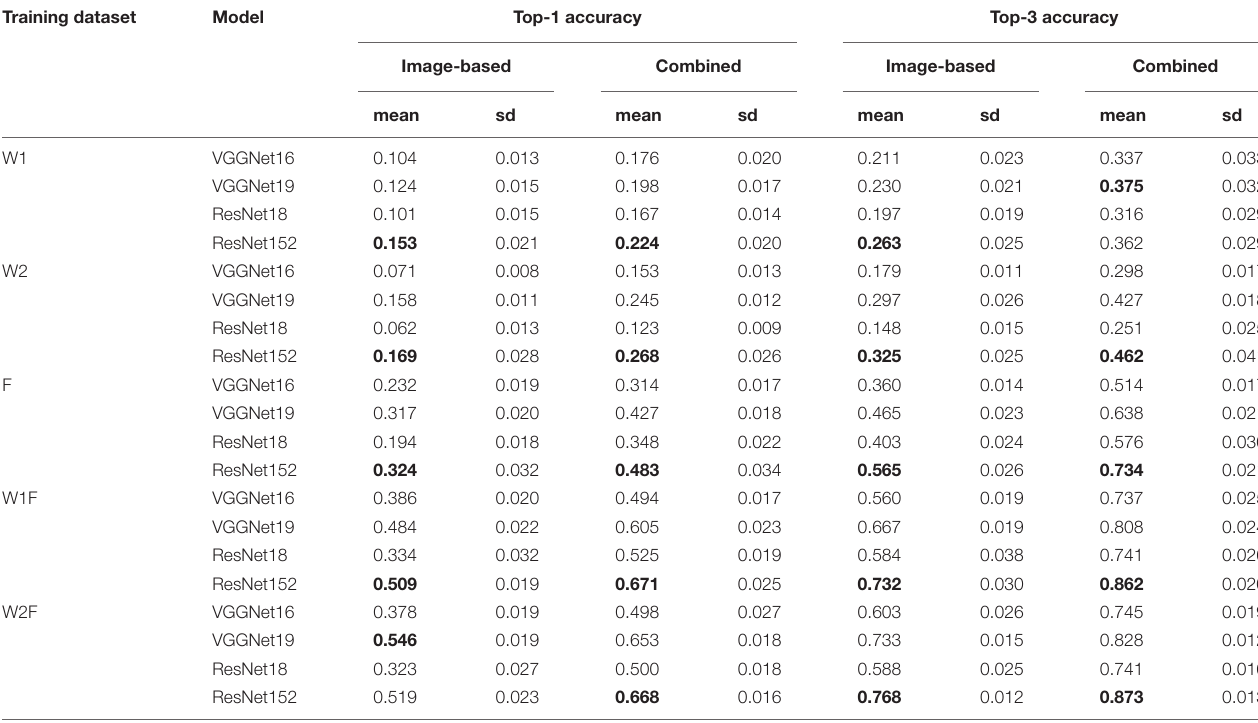
TABLE 2 | The top-1 and top-3 accuracies of image-based and combined models for species identification. Training